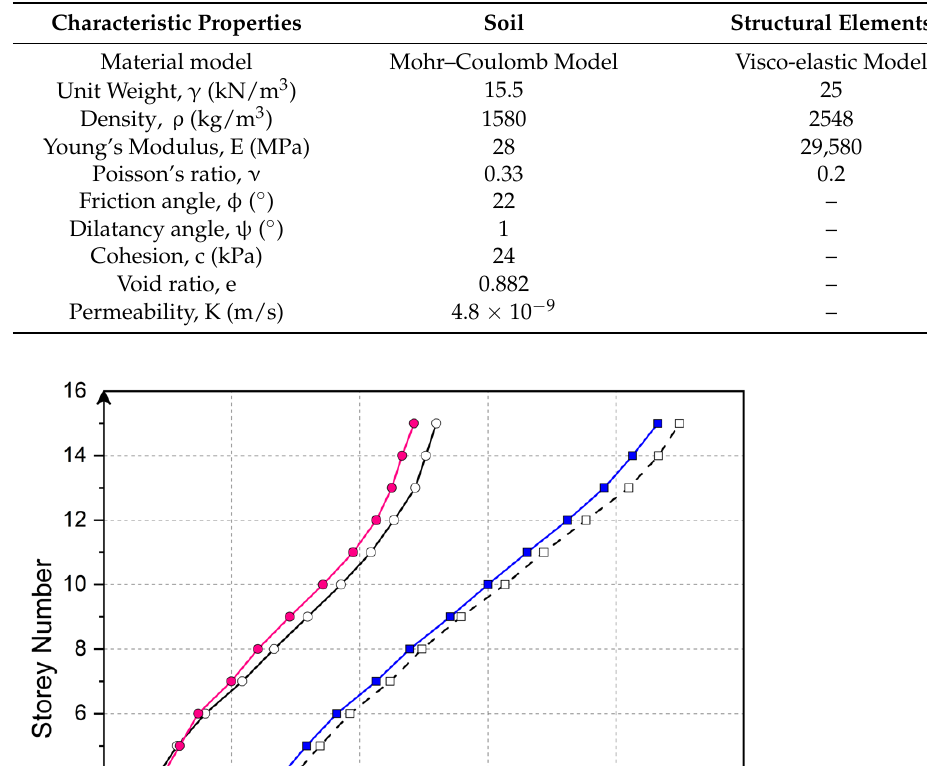
Table 2. Material properties used in the study.